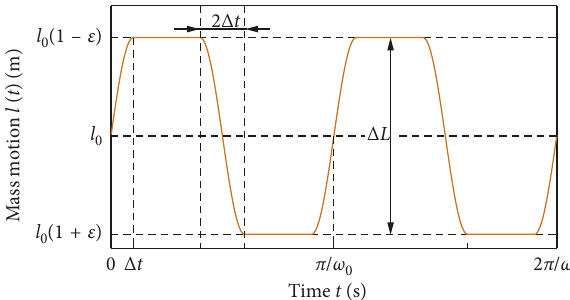
Figure 4: The first two cycles of the mass motion represented by equation